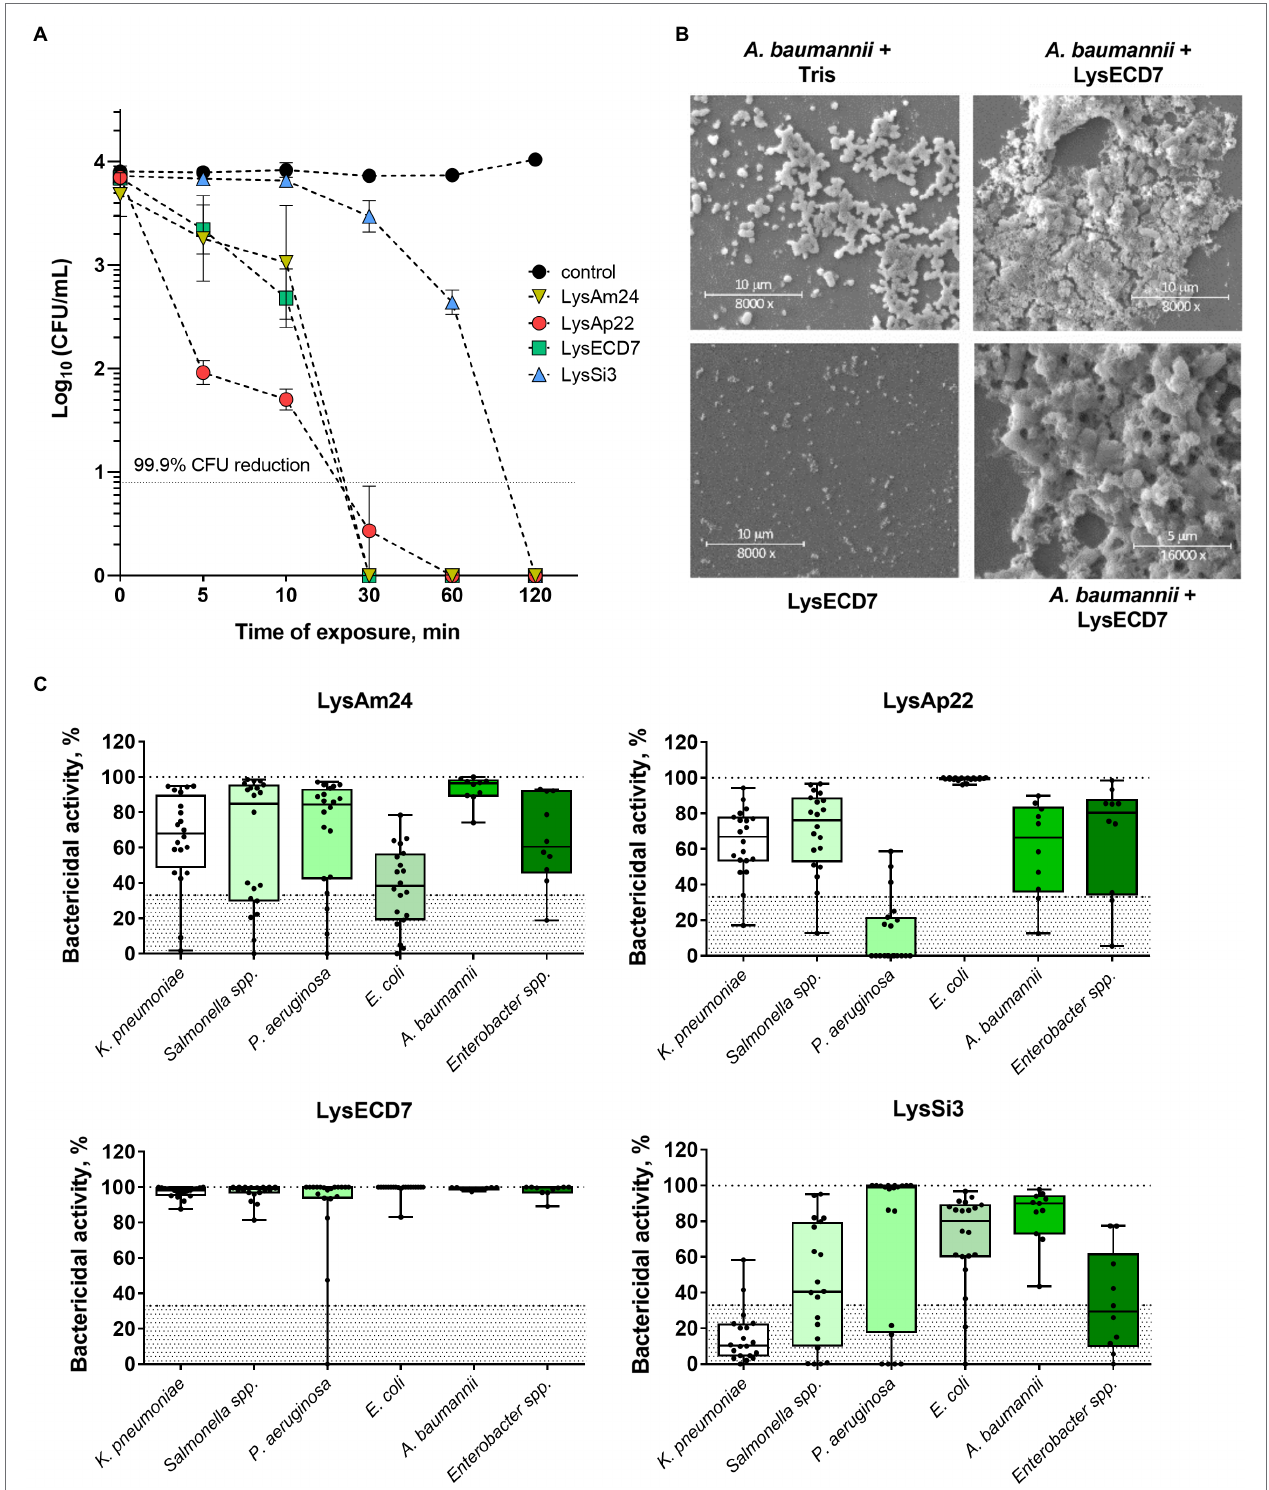
FIGURE 1 | In vitro efficacy of four endolysins. (A) Time-kill curve of endolysins activity in 100 μ g/ml concentration against logarithmic-phase growing planktonic Acinetobacter baumannii Ts 50-16 cells. Data are shown as mean ± SEM. (B) Scanning electron microscopy of A. baumannii Ts 50-16 planktonic cells exposed to 50 μ g/ml of LysECD7 or Tris–HCl buffer for 30 min, or protein in Tris–HCl buffer. (C) LysAm24, LysECD7, LysAp22, and LysSi3 (100 μ g/ml) spectra of activity after a 30-min incubation with logarithmic-phase growing bacteria. Each dot represents a single strain within the species, lines,